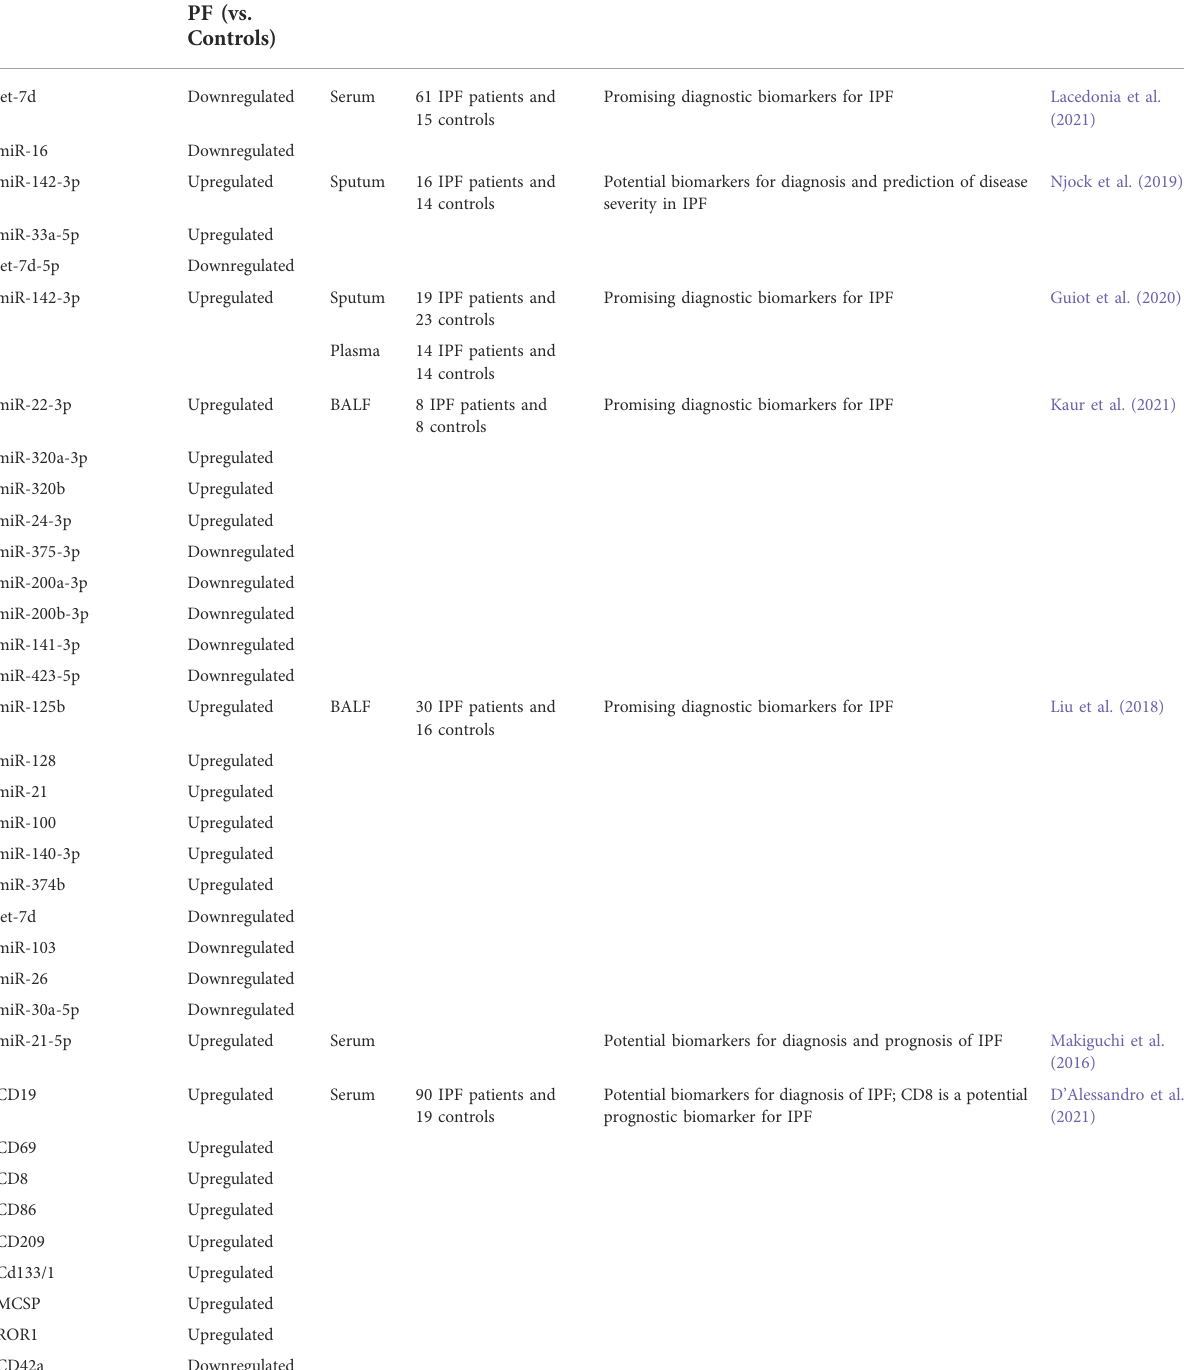
TABLE 1 Biomarker potential of exosomes in